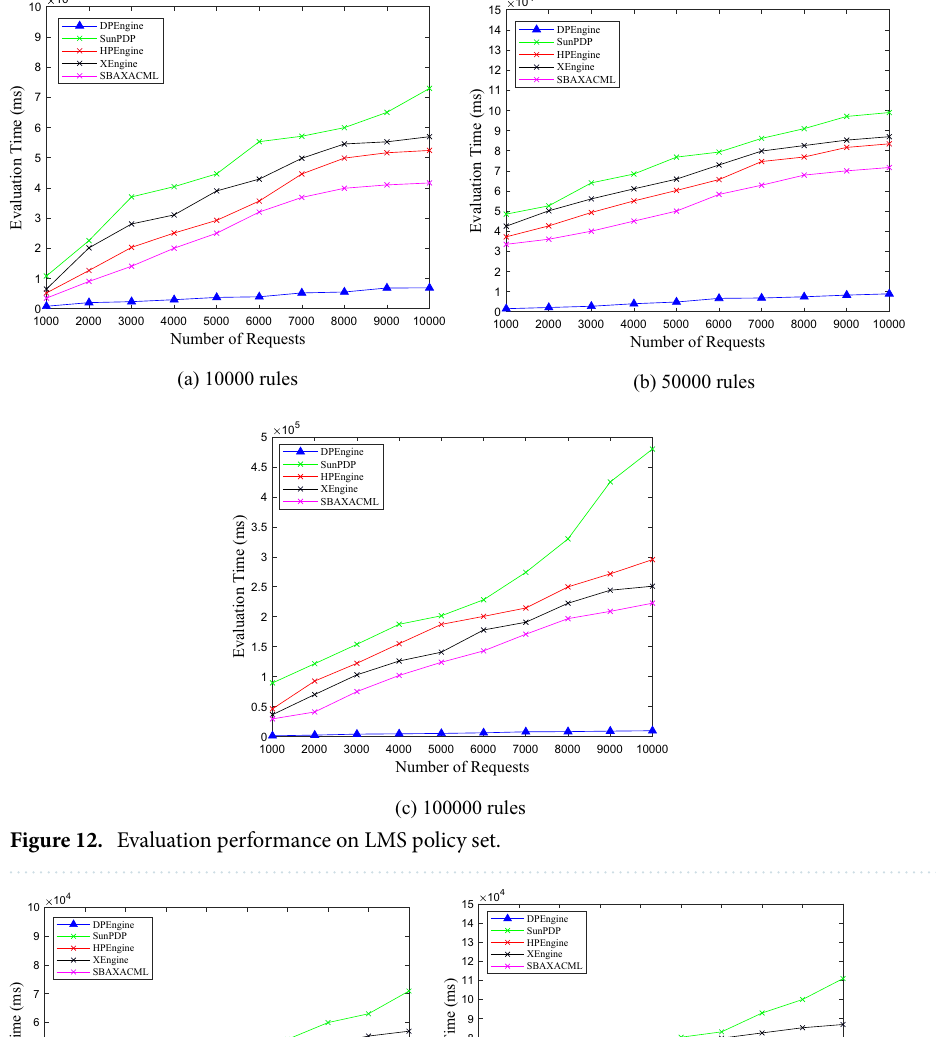
Figure 12. Evaluation performance on LMS policy set.